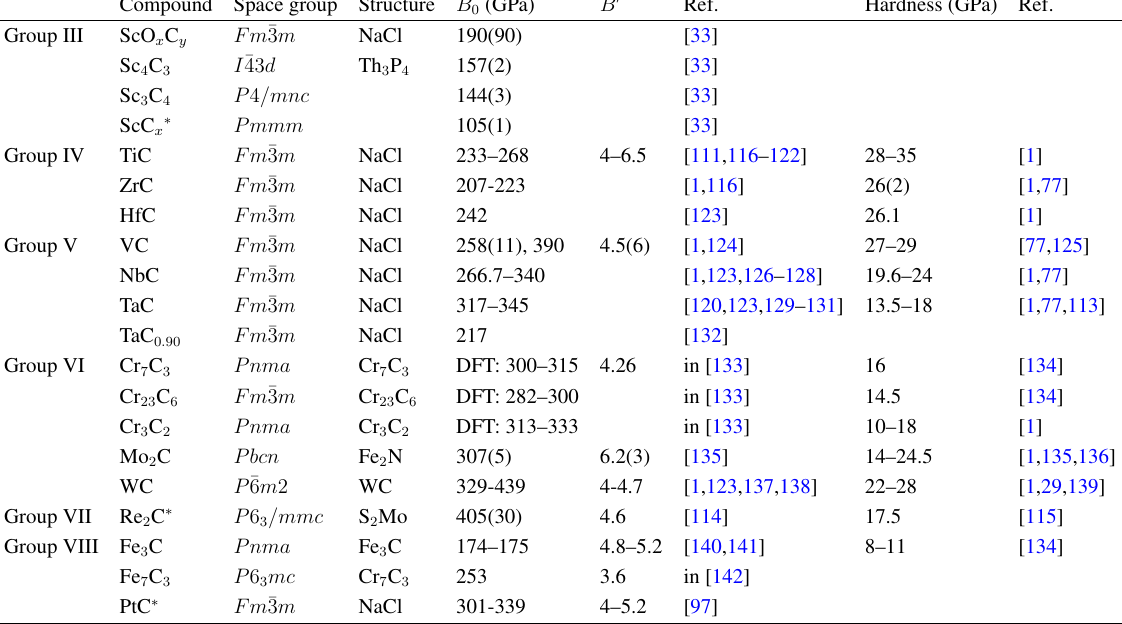
Table 2. Properties of selected transition metal carbides. B pressure derivative. ∗ indicate phases obtained at high-( p, T )